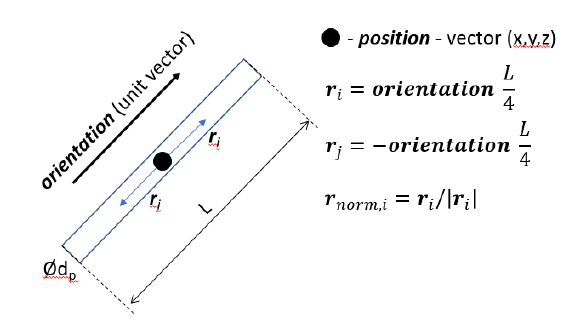
Fig. 1. Description of fibre position and